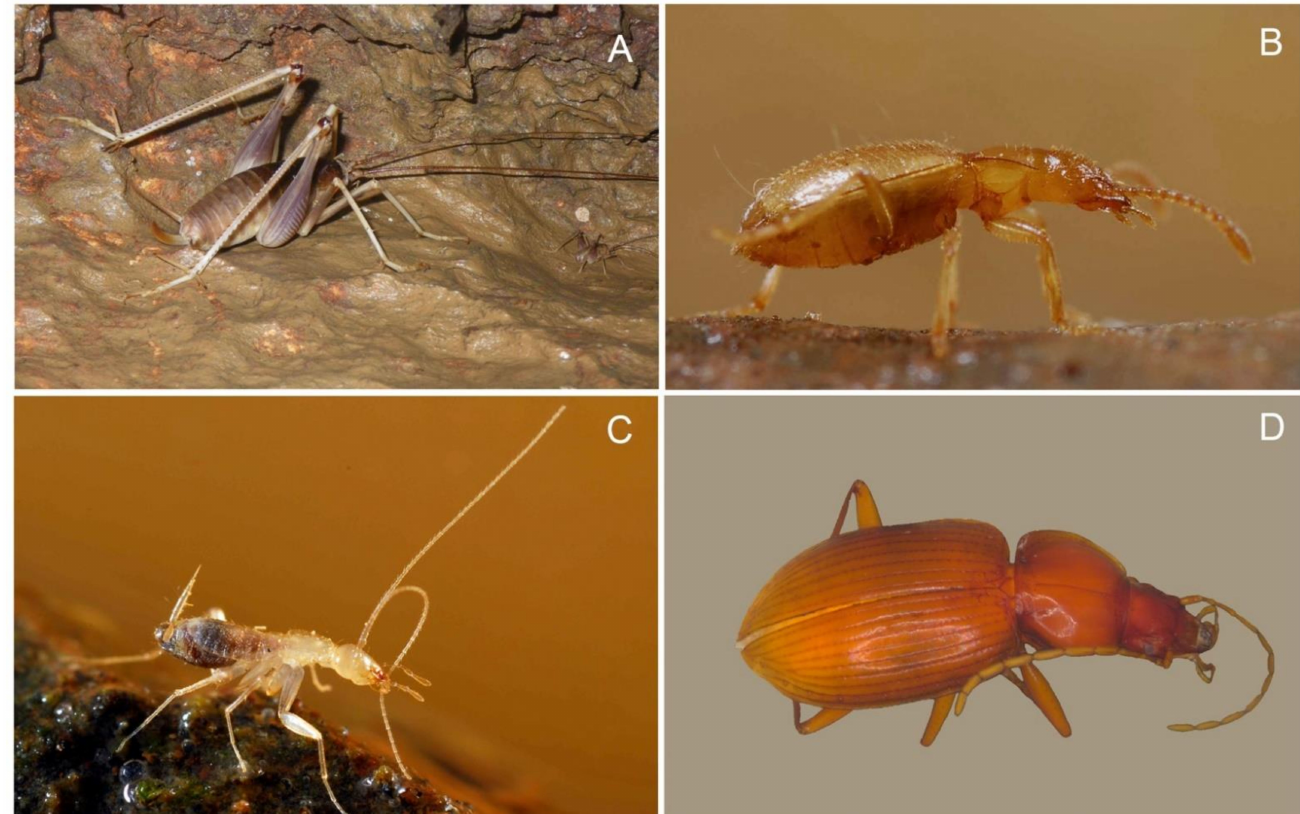
Figure 8. ( A ) Rhaphidophora sp. from Saripa spring cave; ( B ) Eustra saripaensis from Leang Saripa; ( C ) Nocticolidae sp. from Leang Saripa; ( D ) Mateuellus troglobioticus from Leang Saripa. Reproduced with permission from Anne Bedos ( A ), Jean-Yves Rasplus ( B , C ) and Louis Deharveng ( D